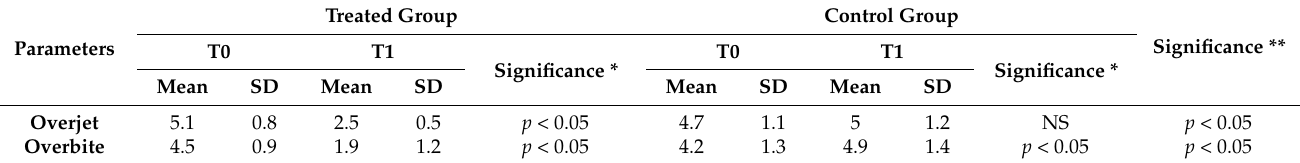
Table 1. Inferential statistics of overjet and overbite detected within treated and control groups. T0 = pre-treatment, T1 = post-treatment, SD = standard deviation * = significance set at p < 0.05 and based on paired Student’s t -test for inter-timing comparisons; ** = significance set at p < 0.05 and based on independent Student’s t -test for intra-timing comparisons.